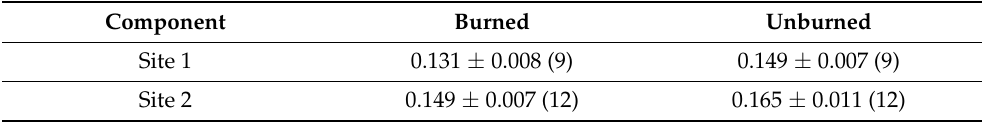
Table 3. Peat bulk density (g cm − 3 ) in burned and unburned treatments in degraded peatlands of Central Kalimantan. Component